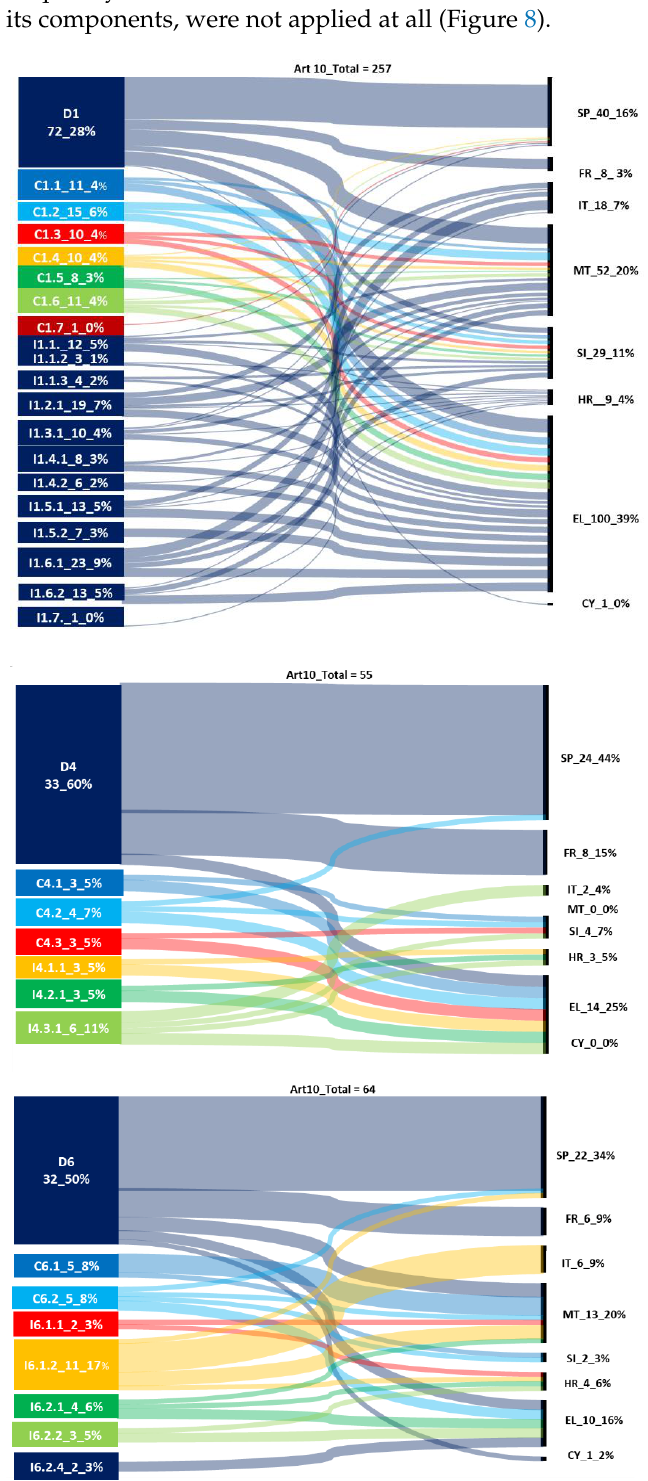
Figure 8. Interrelation of 2012 established environmental targets and associated indicators with Com Dec 2010/477/EU criteria and indicators for biodiversity descriptors (MT and CY did not establish targets for D4).